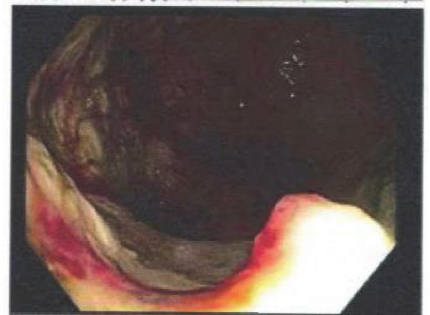
Figure 1: Ulcerated gastric antral mass.